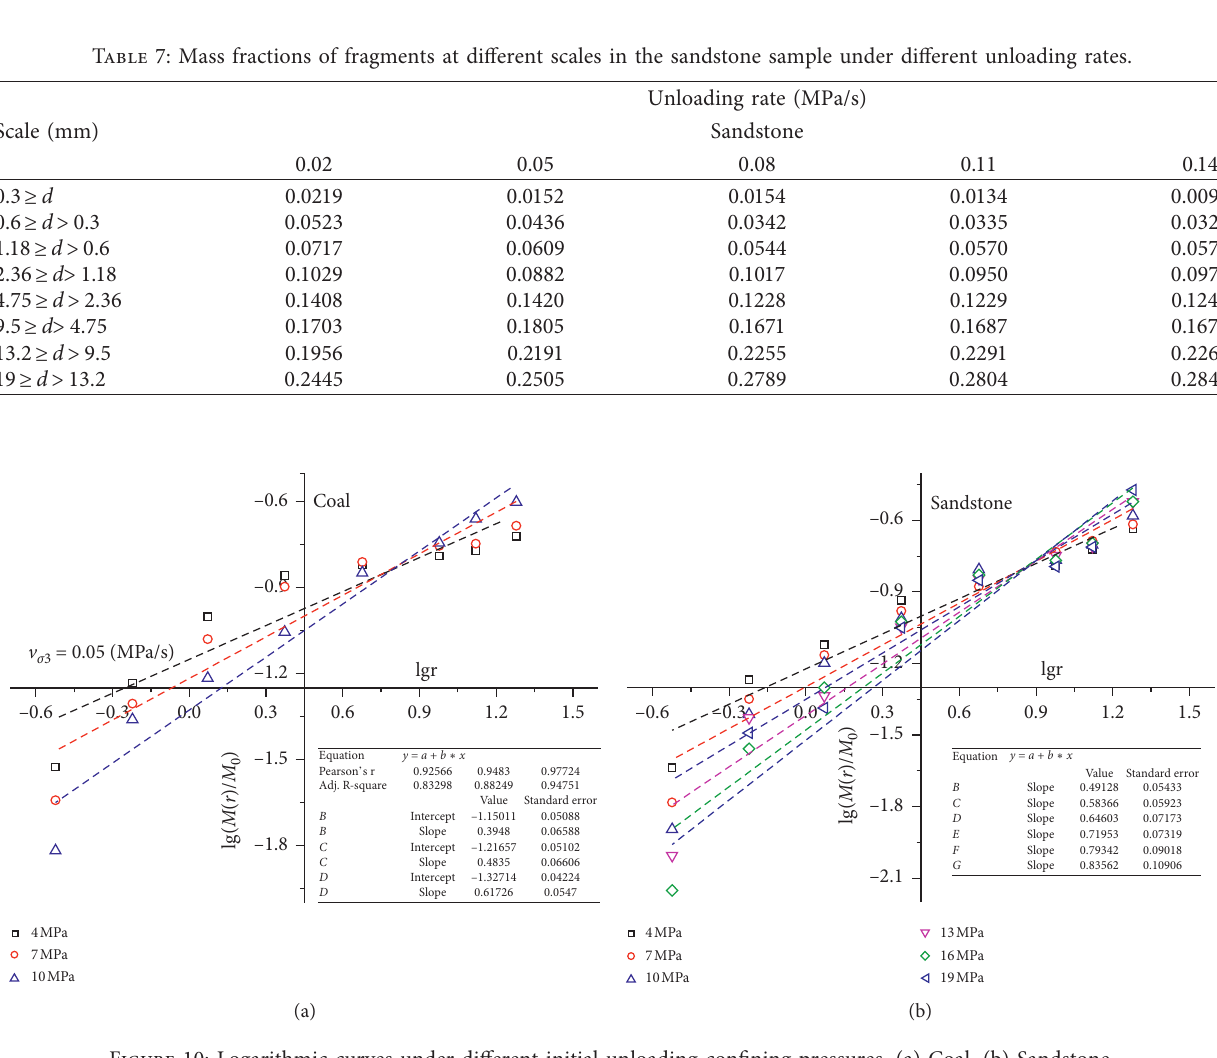
Figure 10: Logarithmic curves under different initial unloading confining pressures. (a) Coal. (b)